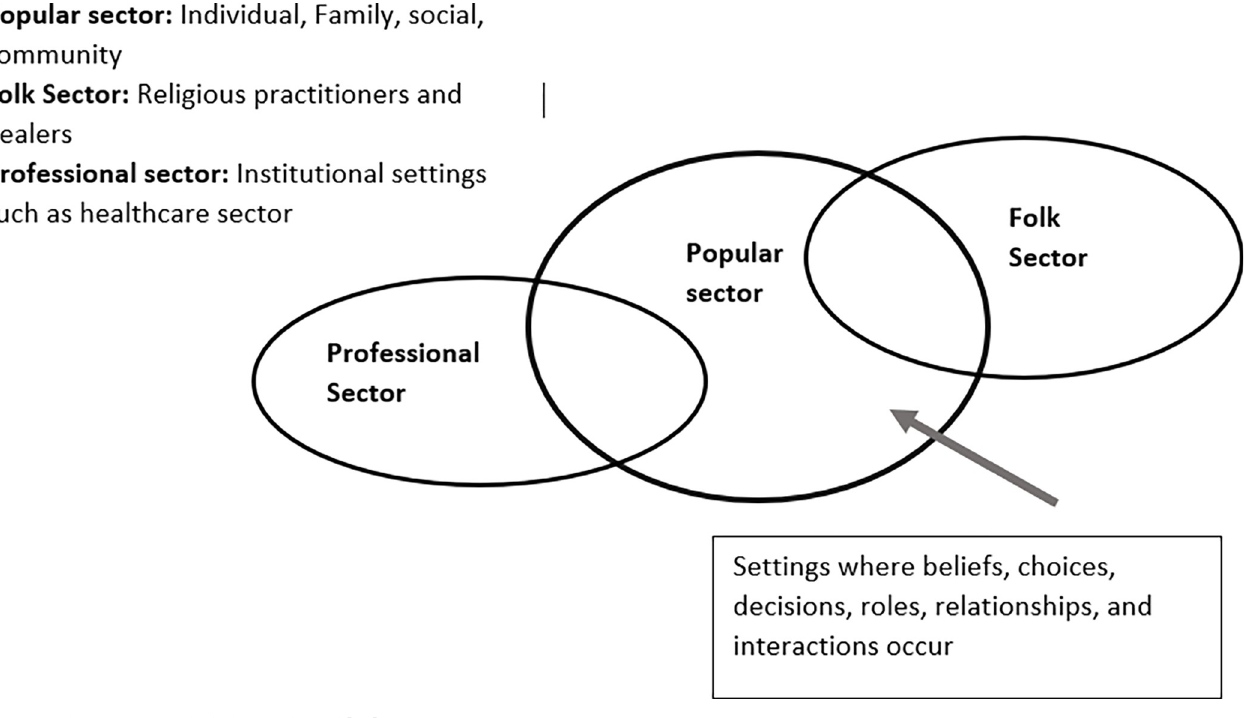
Fig 2. Explanatory model of illness adapted